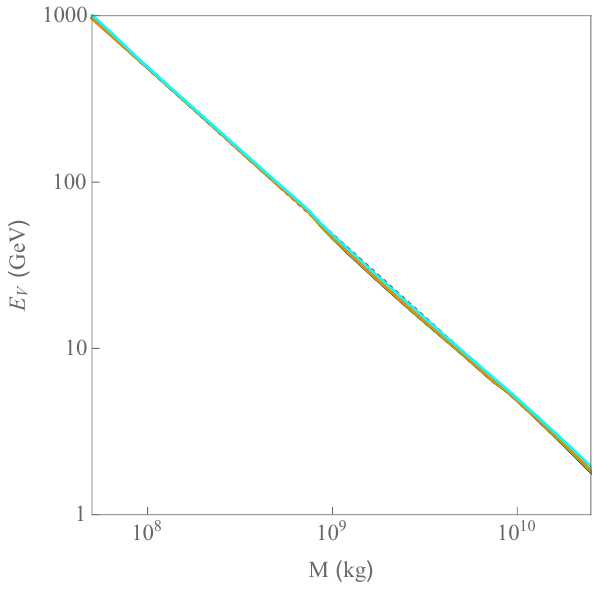
Figure 8 . Primary peak and “valley” energy as a function of the PBH mass for spin parameters a ∗ = 0 , 0 . 1 , 0 . 2 , 0 . 3 , 0 . 5 (red, blue, green, orange and cyan, respectively), computed using BlackHawk. The dotted red line yields the best fit curve for E V given by eq. (4.1).